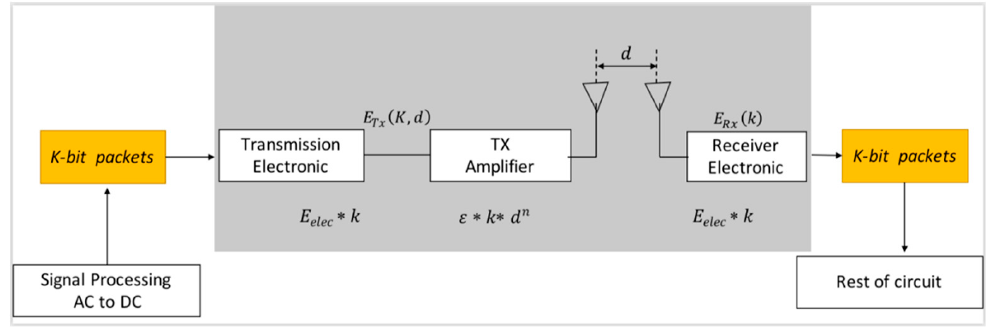
Figure 2. Radio Model used for Probabilistic and Deterministic Tree-based Routing for WSNs (PDTR).